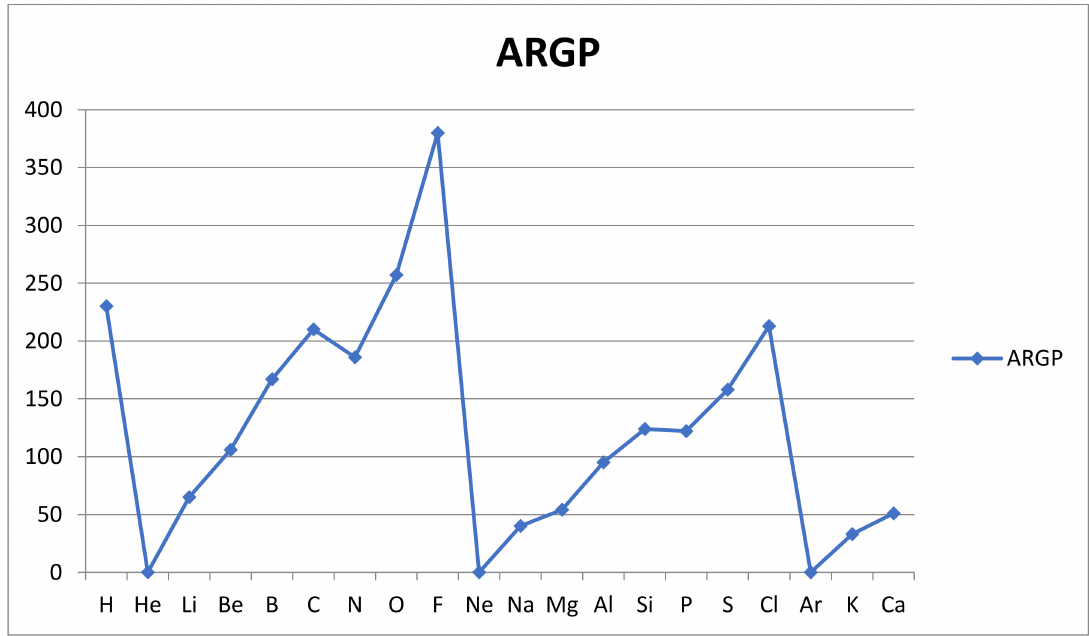
Figure 3. The atomic reactivity measure AR GP (A) in kJ/mol is shown for the atoms A from hydrogen to